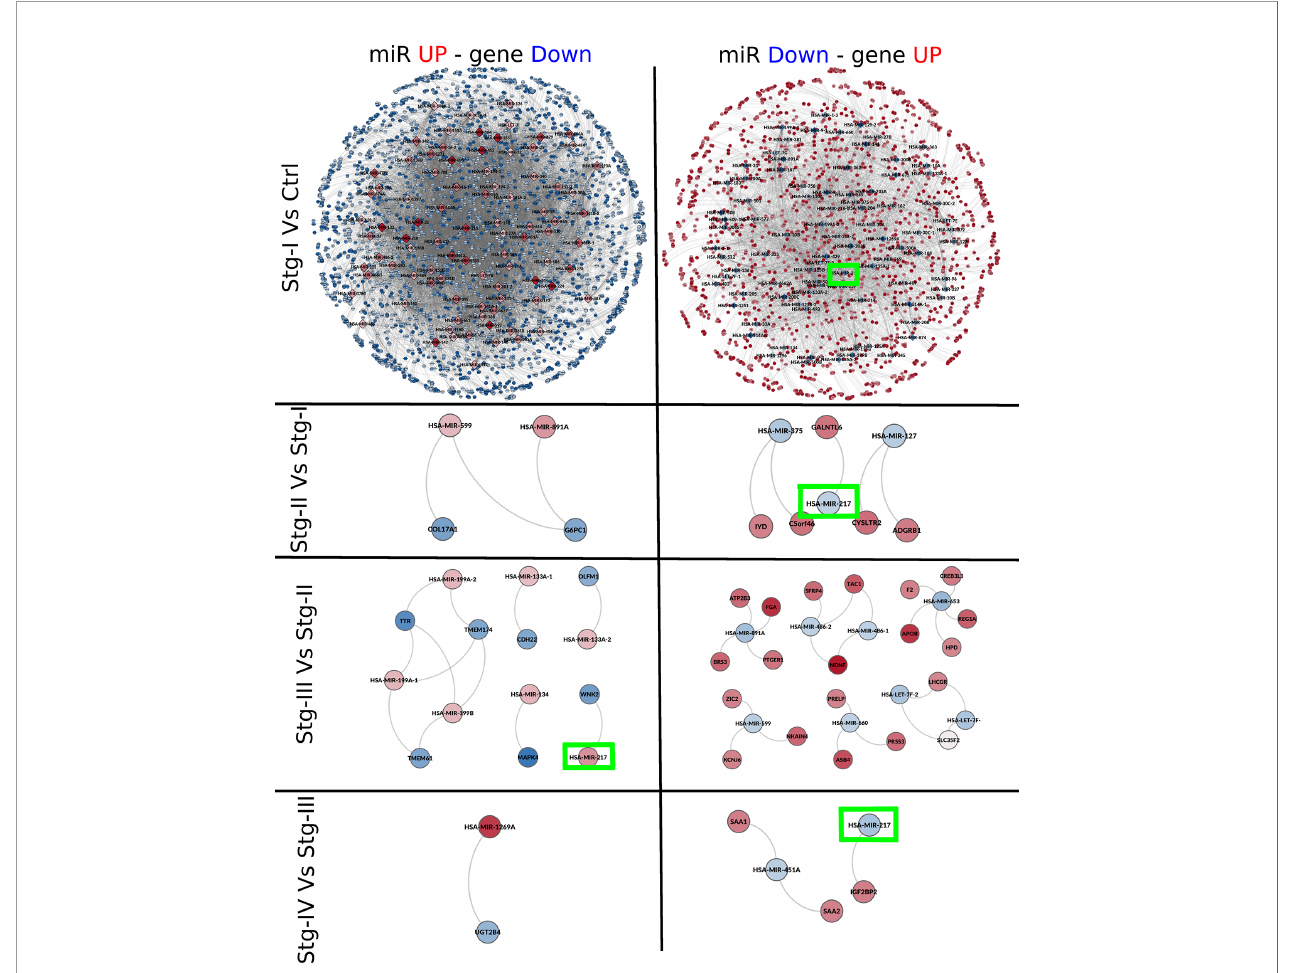
FIGURE 5 | miR – gene networks for each progression stage. In this fi gure, we can observe networks inferred by mutual information between the expression of miRs and genes for each progression stage. Networks are placed from top to bottom according to the progression stage. The contrast used to depict each network is placed at the left. Red nodes represent overexpressed miRs or genes; meanwhile, underexpressed molecules are depicted in blue. At the left side, networks constructed with overexpressed miRs and underexpressed genes can be found. The right part of the fi gures contains networks with underexpressed miRs and overexpressed genes. Green squares mark the location of miR-217, the only micro-RNA present in the four